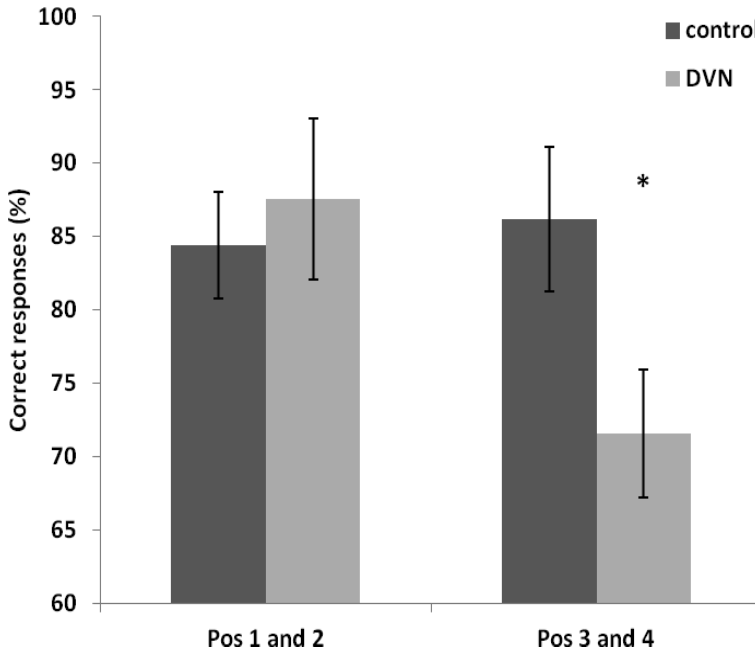
Figure 3 Percentage of participants’ correct responses in the condition when the dynamic visual noise (DVN) was present during encoding, according to the serial position of test stimulus * p < .05. Error bars represent standard errors of